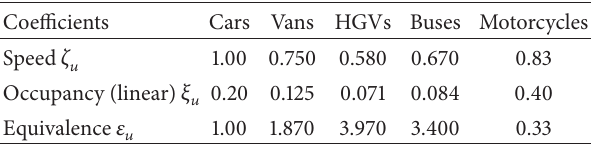
Table 2: Parameters adopted for the classes of modal units consid- ered in the